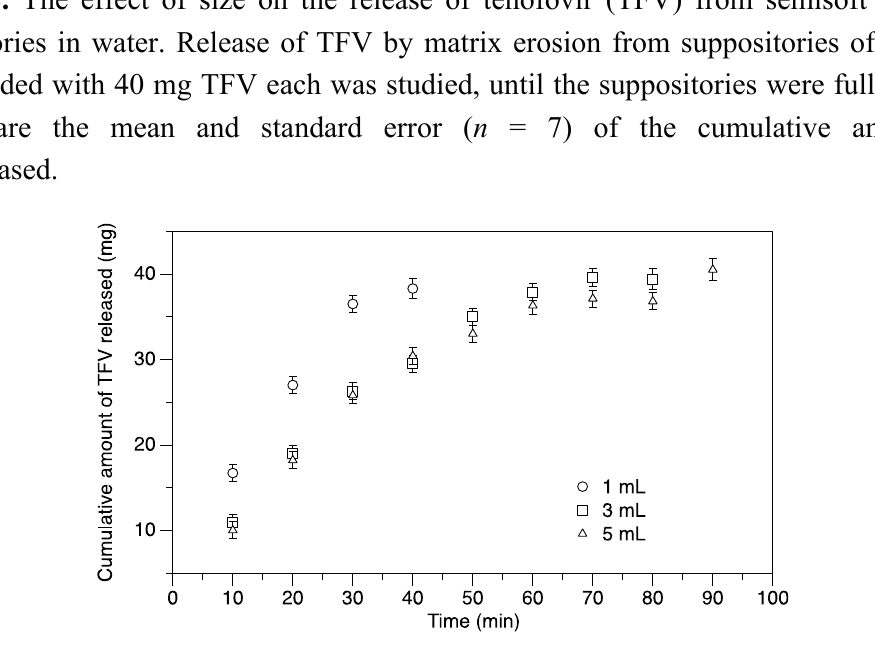
Figure 3. The effect of size on the diffusion of TFV from spherical carrageenan suppositories in: ( A ) 80 mL of vaginal simulant fluid (VSF); ( B ) 5 mL of VSF; ( C ) 80 mL of semen simulant fluid (SSF); and ( D ) 5 mL of SSF. The release of TFV by diffusion from suppositories 1, 3 and 5 mL loaded with 40 mg TFV each was studied for 24 h. Plotted are the mean and standard error ( n = 7) of the cumulative amount of TFV